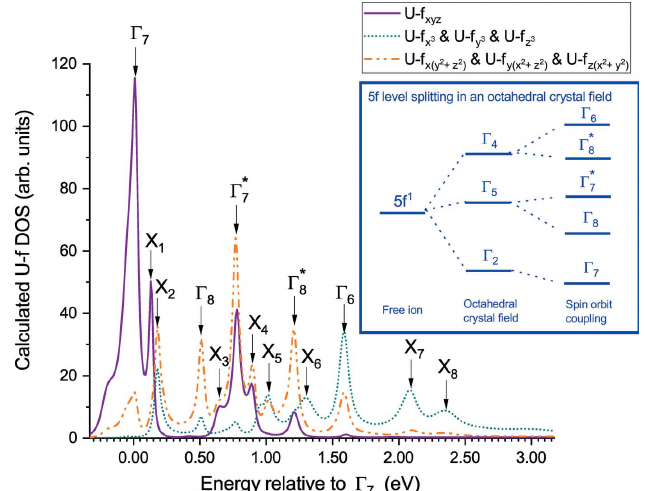
Figure 5 Uranium 5 f level crystal field splitting as deduced from the calculated DOS. Those peaks are contributing to the white line intensity in the U M 4 -edge HERFD-XANES spectra. U- f states are here represented as cubic